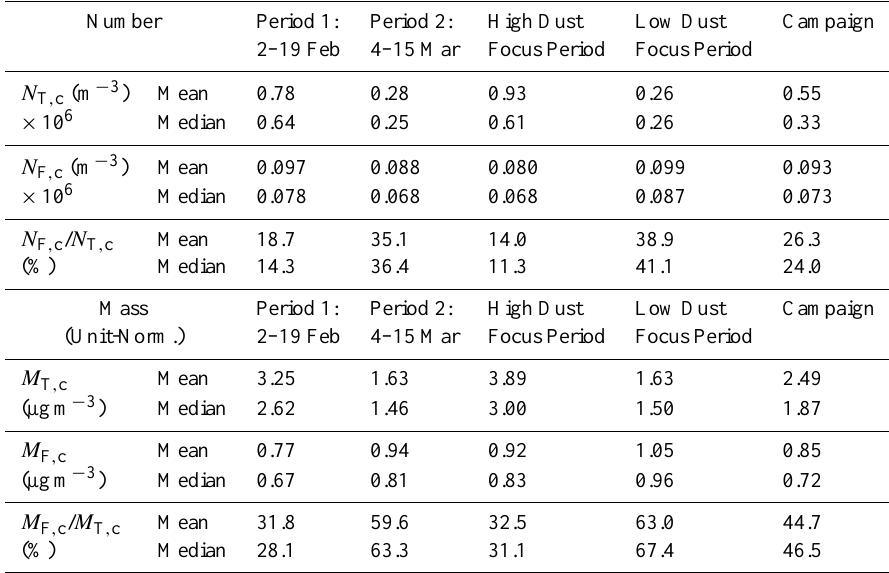
Table 1. Integrated number and unit-normalized mass concentrations of coarse FBAP and total particles (1–20µm). Arithmetic mean and median values shown for: Period 1 (2–19 February 2008), Period 2 (4–15 March 2008), High Dust focus period (2867min average), Low Dust focus period (5608min average), and entire campaign.